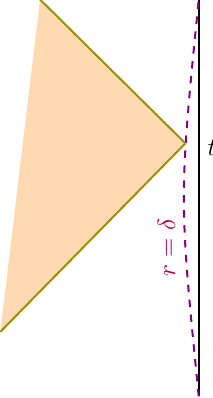
Figure 2 . One half of the WDW patch near the right boundary of